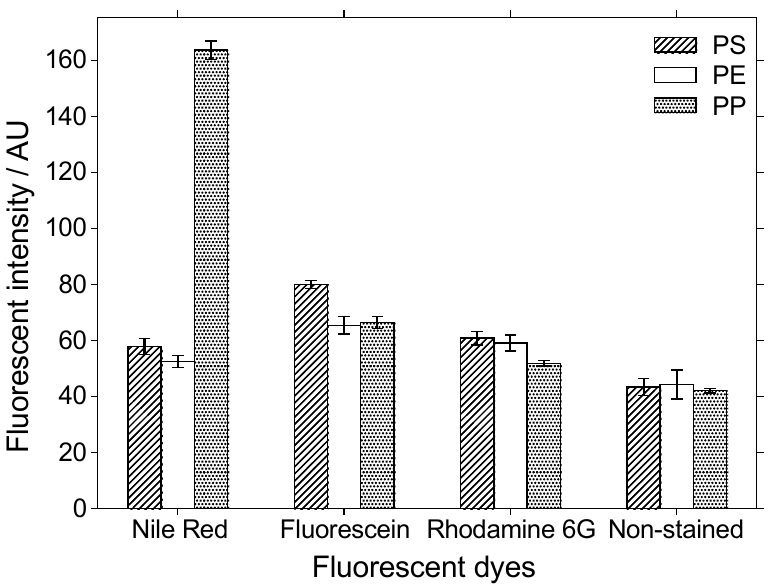
Figure 4. Bar graph illustrating the fluorescent intensity values of stained and non-stained PS, PE, and PP microplastics using ethanolic solutions of Nile Red, Fluorescein, and Rhodamine 6G fluorescent dyes ( n ≥ 6).